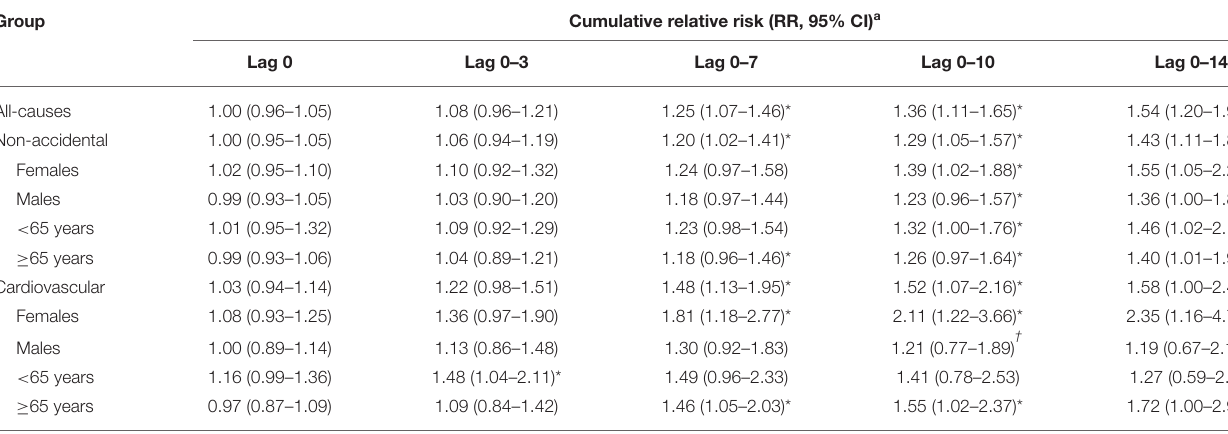
TABLE 3 | Summary of cumulative relative risk of the cold spell on mortality at lag 0–14 days under the best definition.